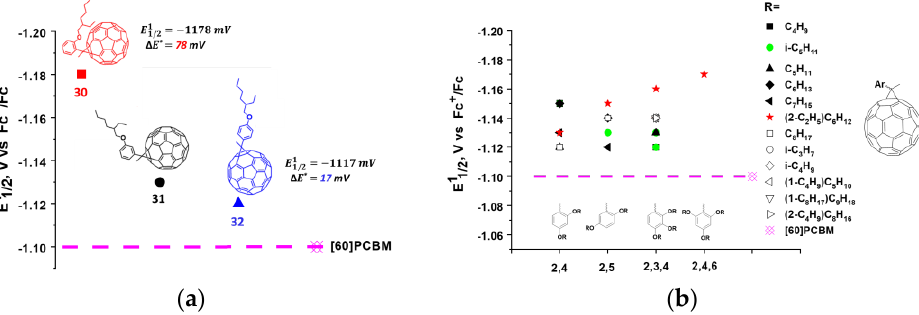
Figure 11. ( a ) Dependence of the first reduction potentials (E 11/2 ) obtained in solution on the position of the alkoxy substituent in the phenyl ring of methanofullerenes 30 – 32 ; ( b ) The effects of the positioning and number of alkoxy substituents in the phenyl fragment on reduction potentials of methanofullerenes.